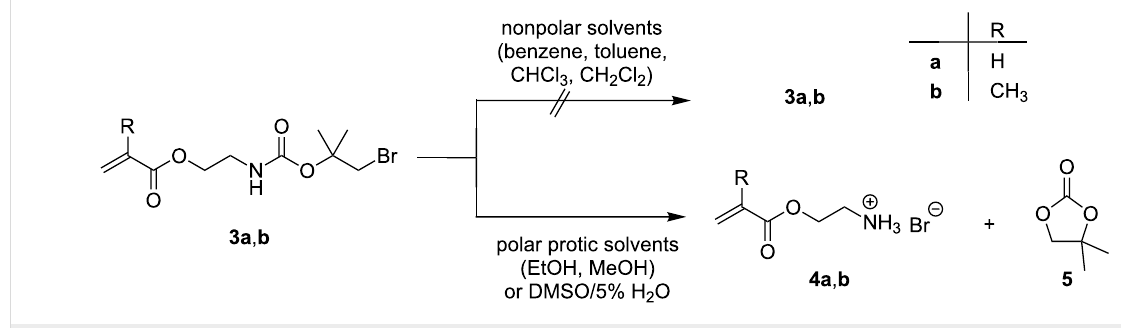
Scheme 2: Stability of 3 in different solvents.